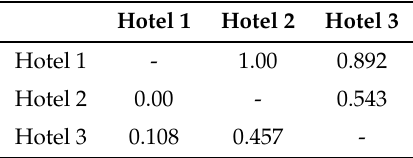
Table 7. Pairwise winning indices: probability of row alternative being better than column